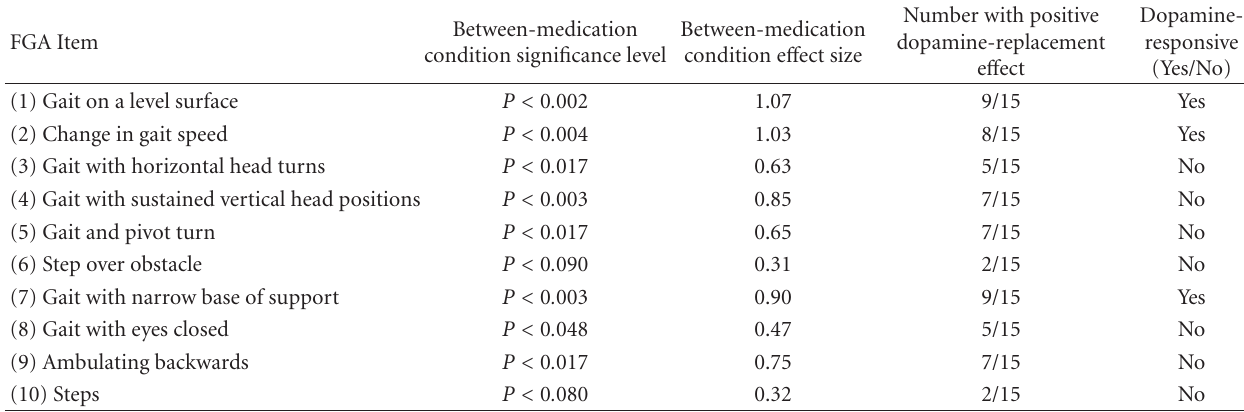
Table 2: FGA item analysis: items were determined to be dopamine responsive if 3 criteria were met: (1) there was statistical significance between medication conditions, ( P < 0 . 005) (2) there was a large e ff ect size (ES > 0.70), and (3) the majority of individuals tested demonstrated a performance improvement with dopamine